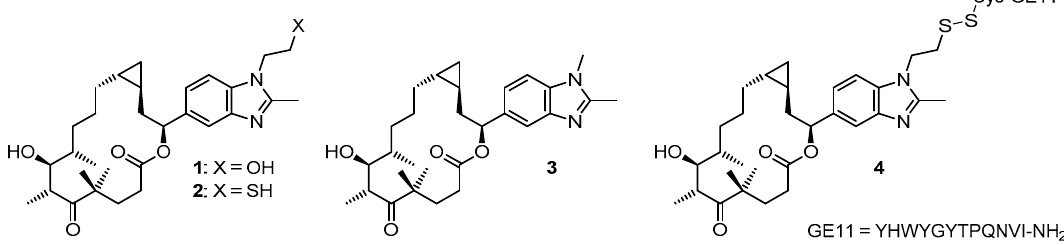
Figure 2. Molecular structures of epothilone analogs 1 – 3 and of the tumor-targeted epothilone peptide conjugate 4 .